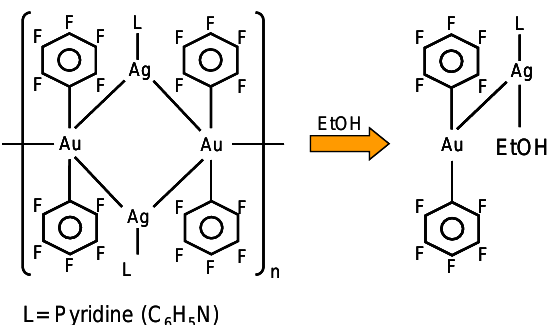
Figure 2. Molecular structure of the vapochromic material employed and its reaction in presence of ethanol